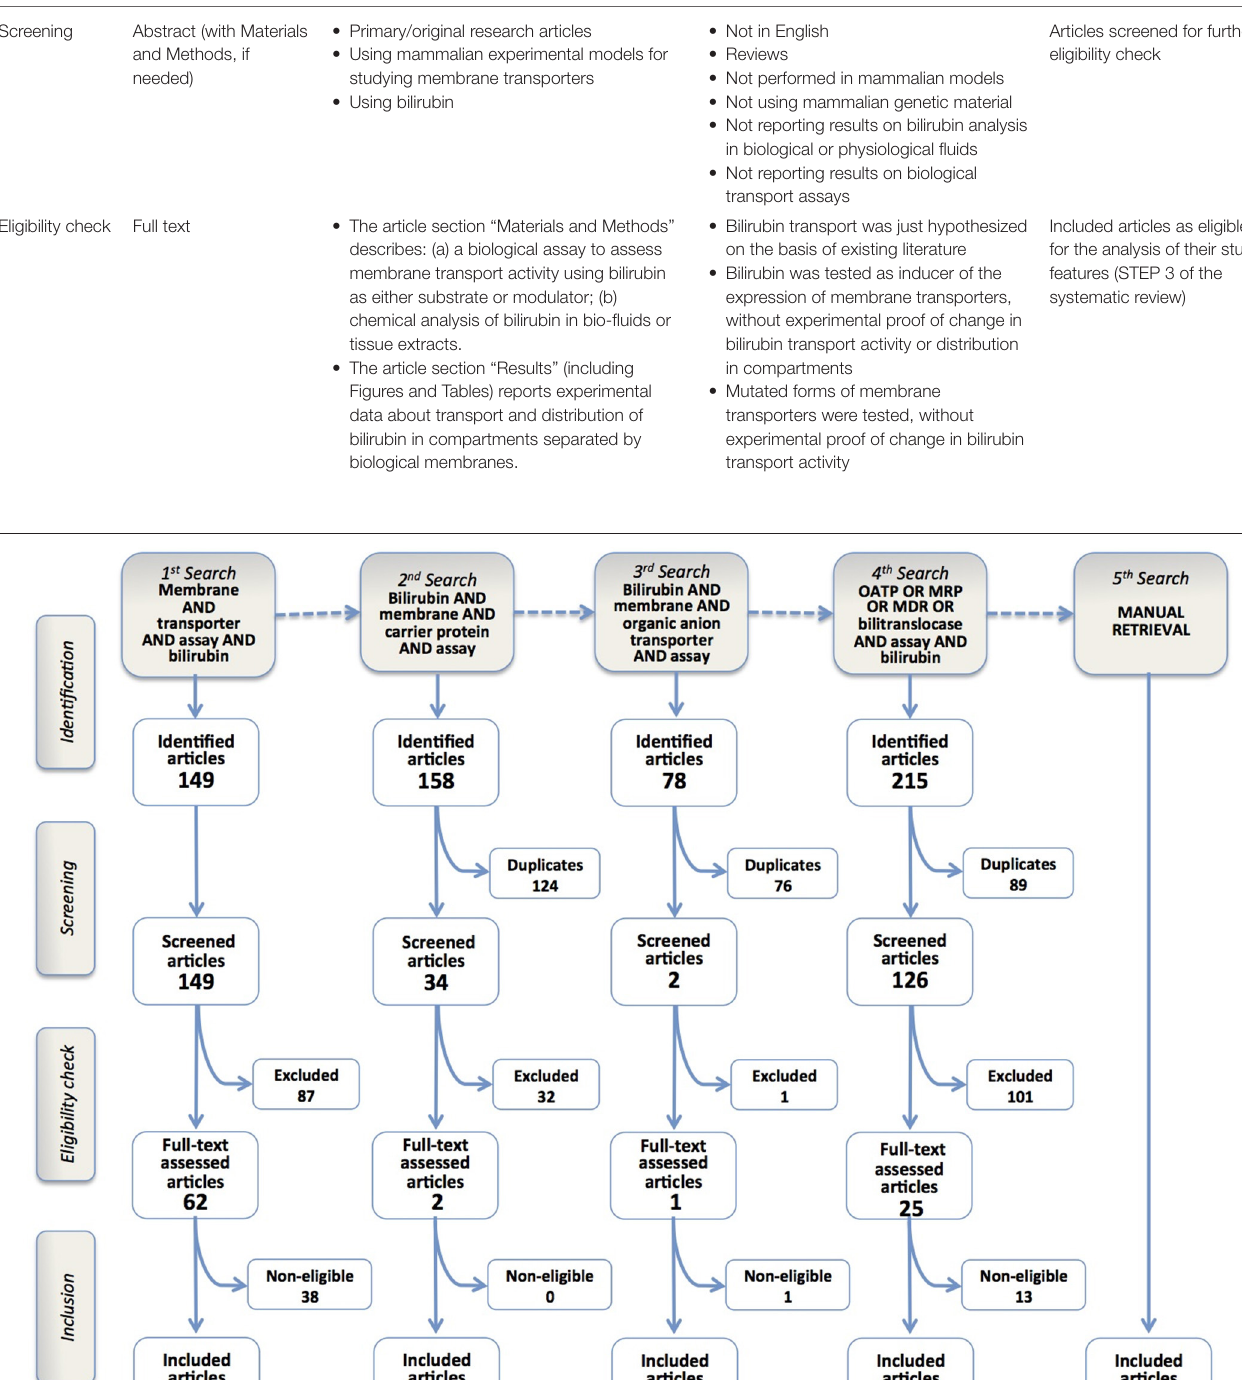
Frontiers in Pharmacology |